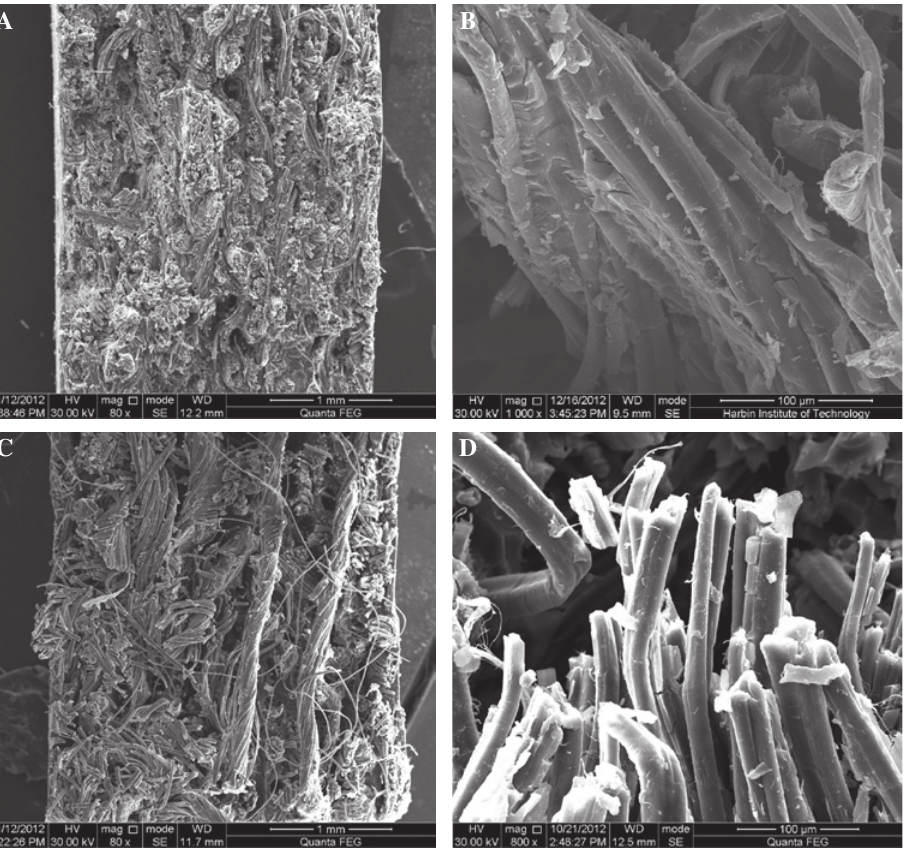
Figure 7 Scanning electron microscope pictures of ramie fiber fabric reinforced phenolic resin (RFRP) fracture surfaces due to tension.